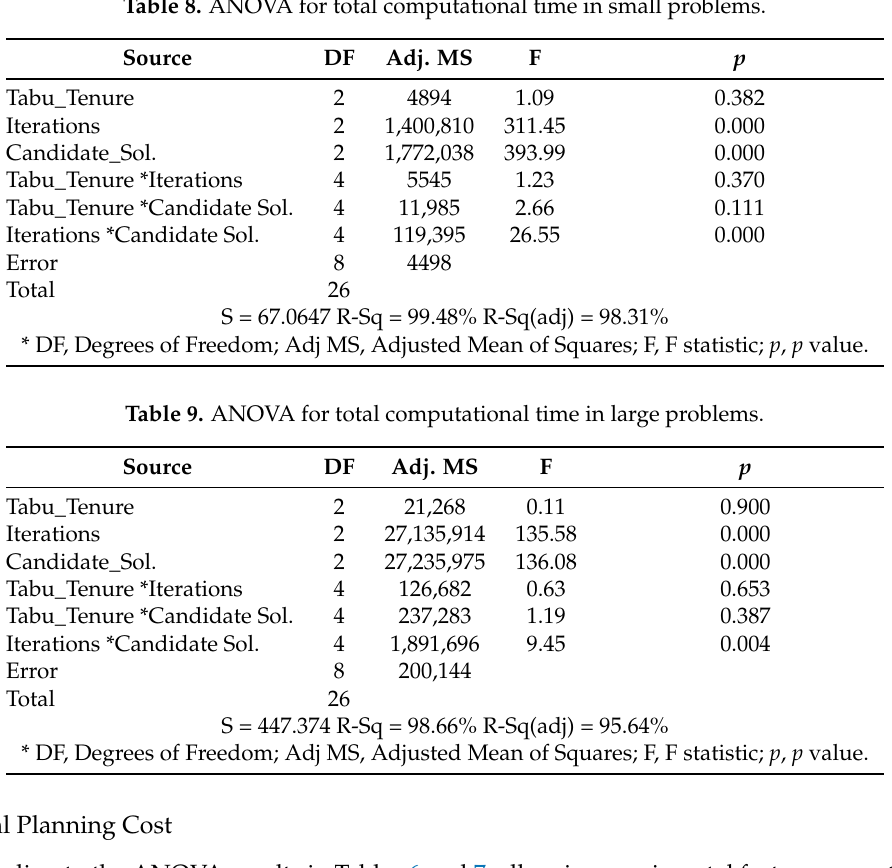
Table 8. ANOVA for total computational time in small problems.